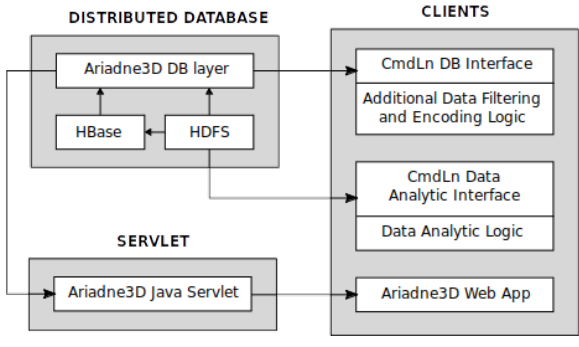
Figure 1. System architecture of